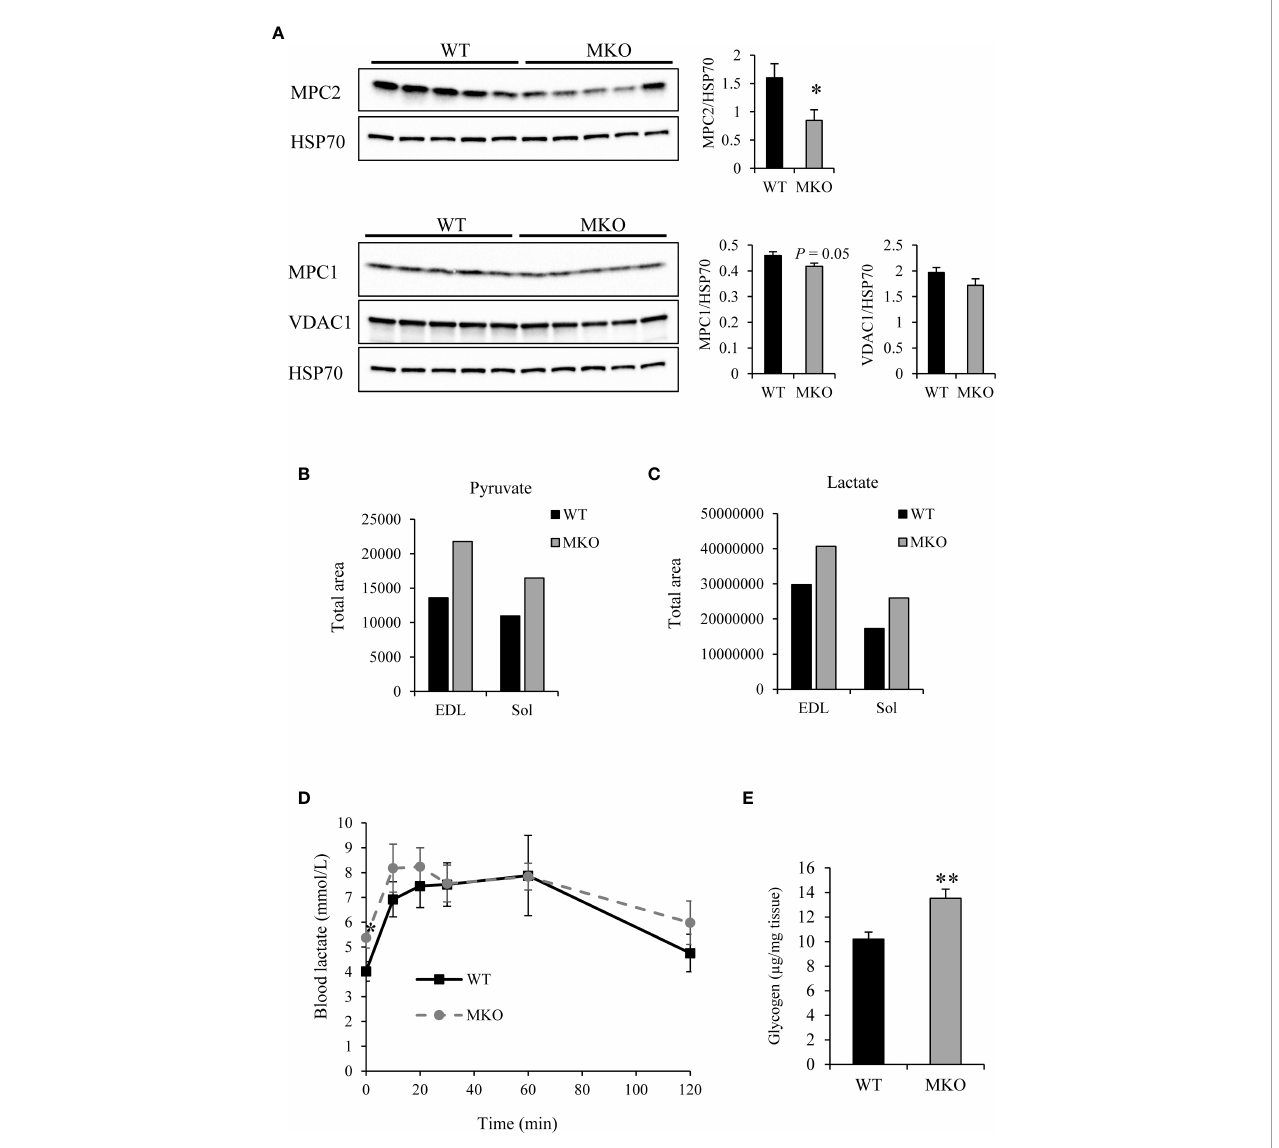
FIGURE 10 Cori cycling was increased in Arid5b MKO mice. (A) Expression of MPC2, MPC1 and VDAC1 were analyzed by Western blot in Arid5b WT and MKO Sol and normalized to HSP70 expression. Quantitation was performed, and results are expressed as the means ± SE. Quantitative mass spectrometry was performed for (B) pyruvate and (C) lactate in Arid5b WT and MKO muscles. (D) Blood lactate was measured during glucose tolerance tests (n=5). *, p < 0.05. (E) Glycogen levels were measured in the liver (n=5). Data are presented as the means ± SE. **, p <